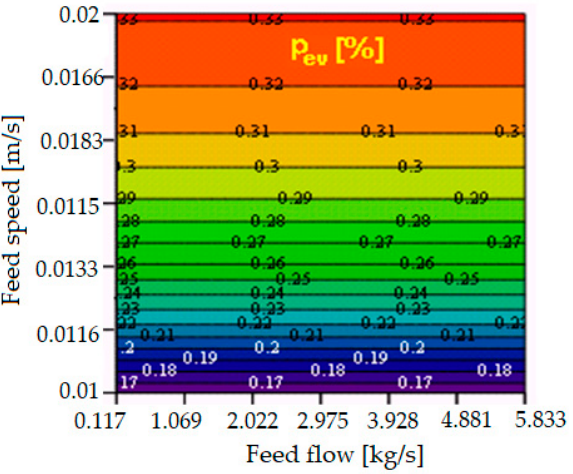
Figure 16. Graphic representation of evacuation losses ( p ev ) as a function of feed speed ( v a ) and feed flow ( Q ) .